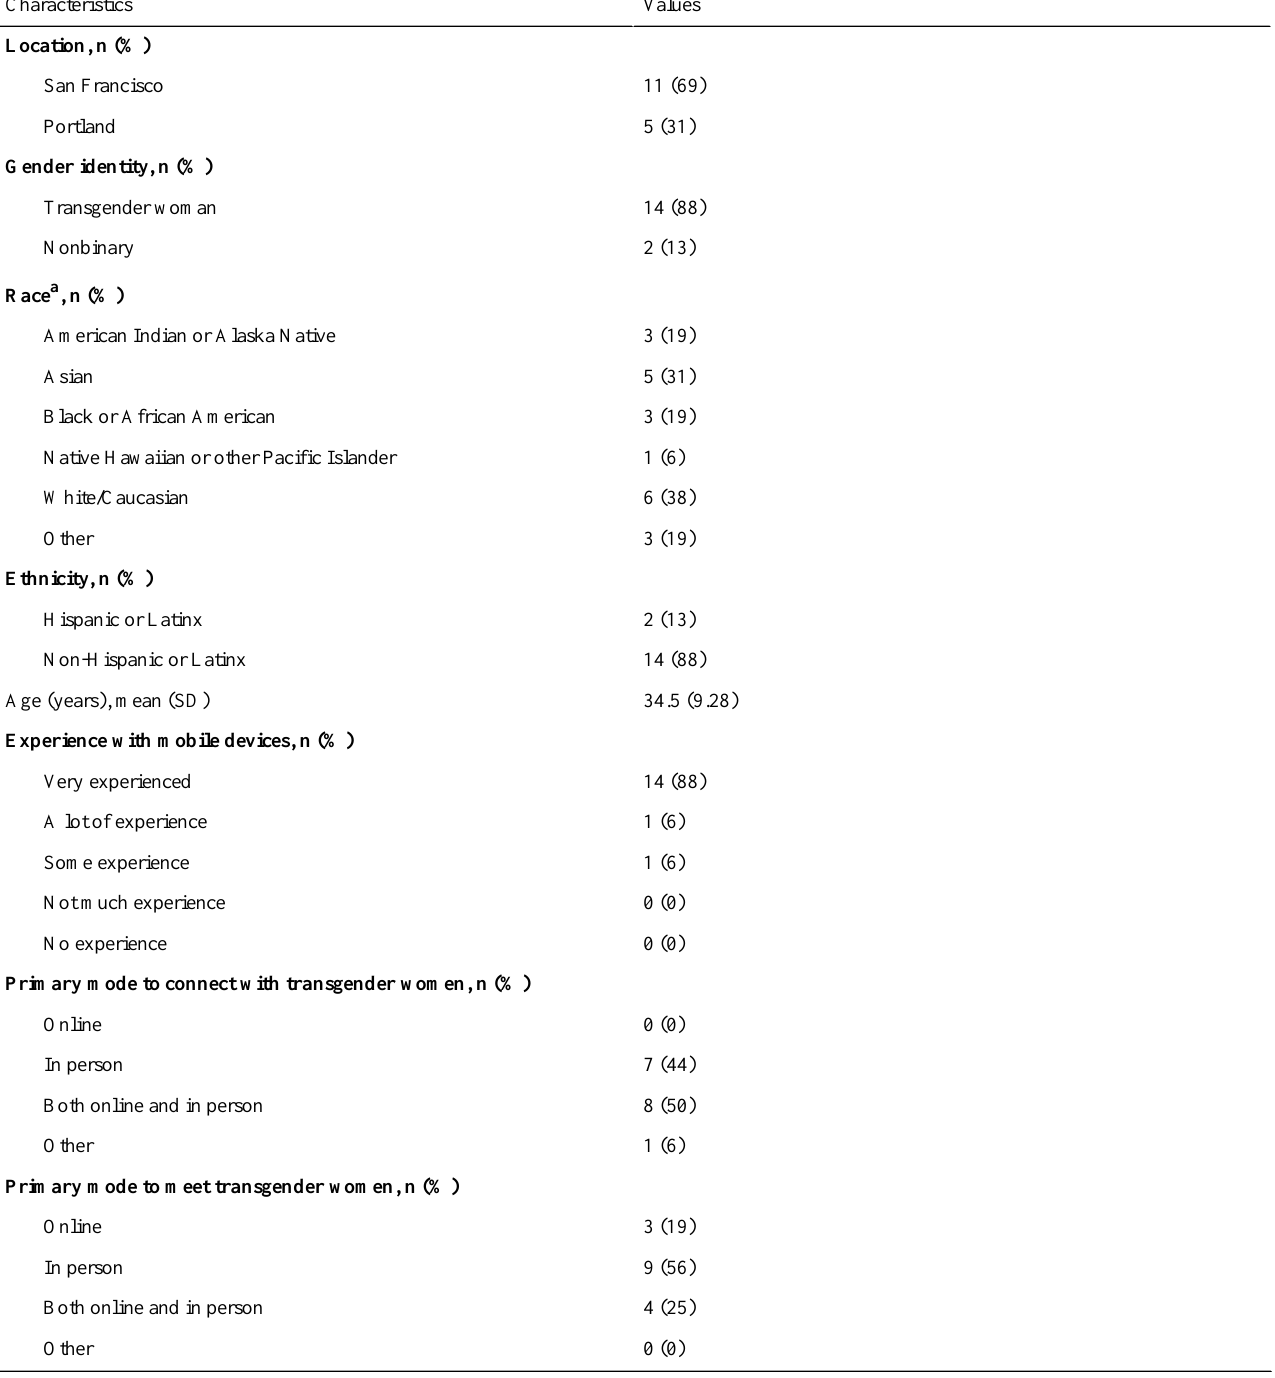
Table 1. Participant characteristics.